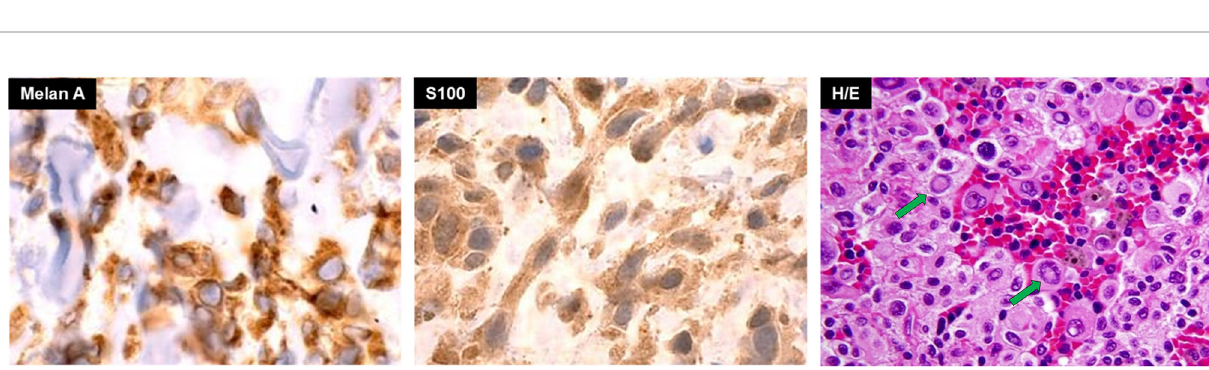
FIGURE 1 | Brain MRI scan at diagnosis in 2016. Extra-axial bulky solid mass with a hypercellular solid component in the right paravermian location depicted by the arrow in (A) (axial T1WI), (B) (GRE), and C (T2WI). Note the hypointense components in T2WI (C) and blooming effect in GRE (B) highly suspicious for melanic or pigmented components. Also, note the coexistent intraparenchymal hematoma [* in (A – D) ]. Mass was fi rmly attached to dural surface compressing right transverse dural sinus (doble arrowhead in D, postcontrast T1WI). In the post-operative scan [ (E) , T1 WI postcontrast], no macroscopic evidence of residual disease in the surgical cavity was noted [white star in (E)